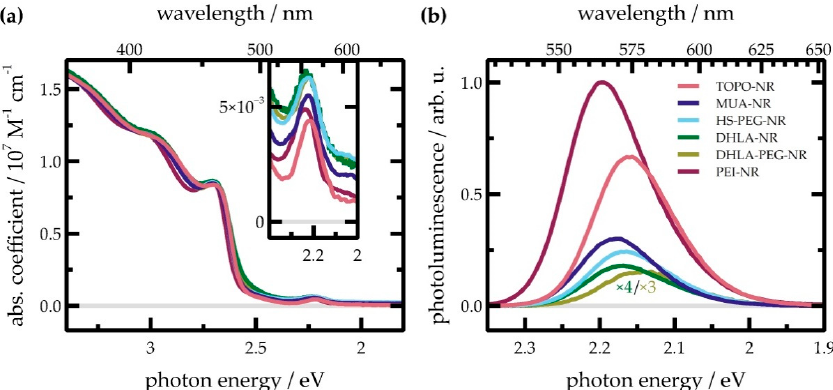
Figure 2. Steady-state spectroscopy on NR capped with di ff erent ligands. TOPO-capped NR (TOPO-NR) were dispersed in toluene, while MUA-, HS-PEG-, DHLA-, DHLA-PEG-, and PEI-NR were dispersed in water. ( a ) Absorption spectra of investigated samples. Absorption coe ffi cients have been estimated using a procedure based on the spectral shape of the absorption spectra [47]. The inset depicts the region of CdSe core absorption. ( b ) Photoluminescence spectra ( λ ex = 450 nm) whose integrals have been normalized to their respective photoluminescence quantum yield. Photoluminescence spectra of DHLA- and DHLA-PEG-NR have been enlarged by a factor of 4 and 3, respectively, for better comparison. Area-normalized photoluminescence spectra can be found in the supporting information (Figure